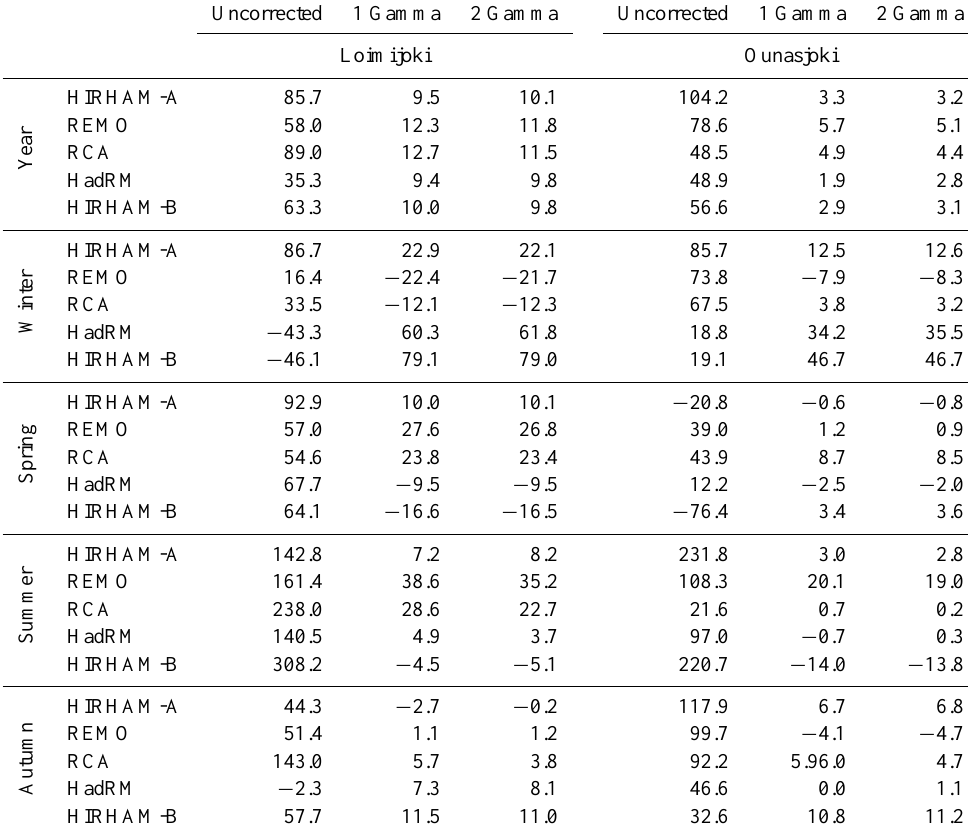
Table 5. Deviation of simulated annual and seasonal mean discharges (MQ) between observed, uncorrected and DBS-adjusted temperature (Gaussian) and precipitation (1 or 2 gamma) as input for hydrological simulations during control period 1961–2000 in %. Values are shown for Loimijoki in southern Finland and Ounasjoki in northern Finland to demonstrate the spatial variation. Uncorrected 1 Gamma 2